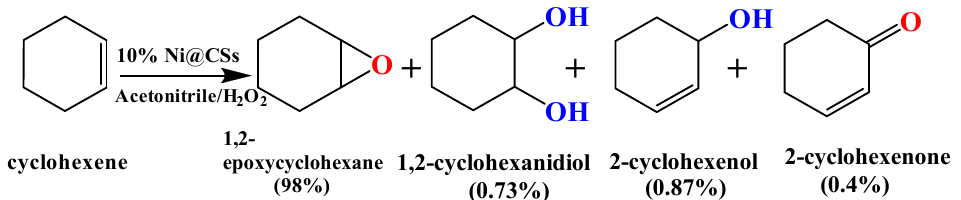
Figure 4. ( a ) Conversion (%) of cyclohexene, and ( b ) selectivity (%) of cyclohexene oxide using 10% Ni@CSs composite (50 mg catalyst, 353 K, pH = 8, and 14 h).